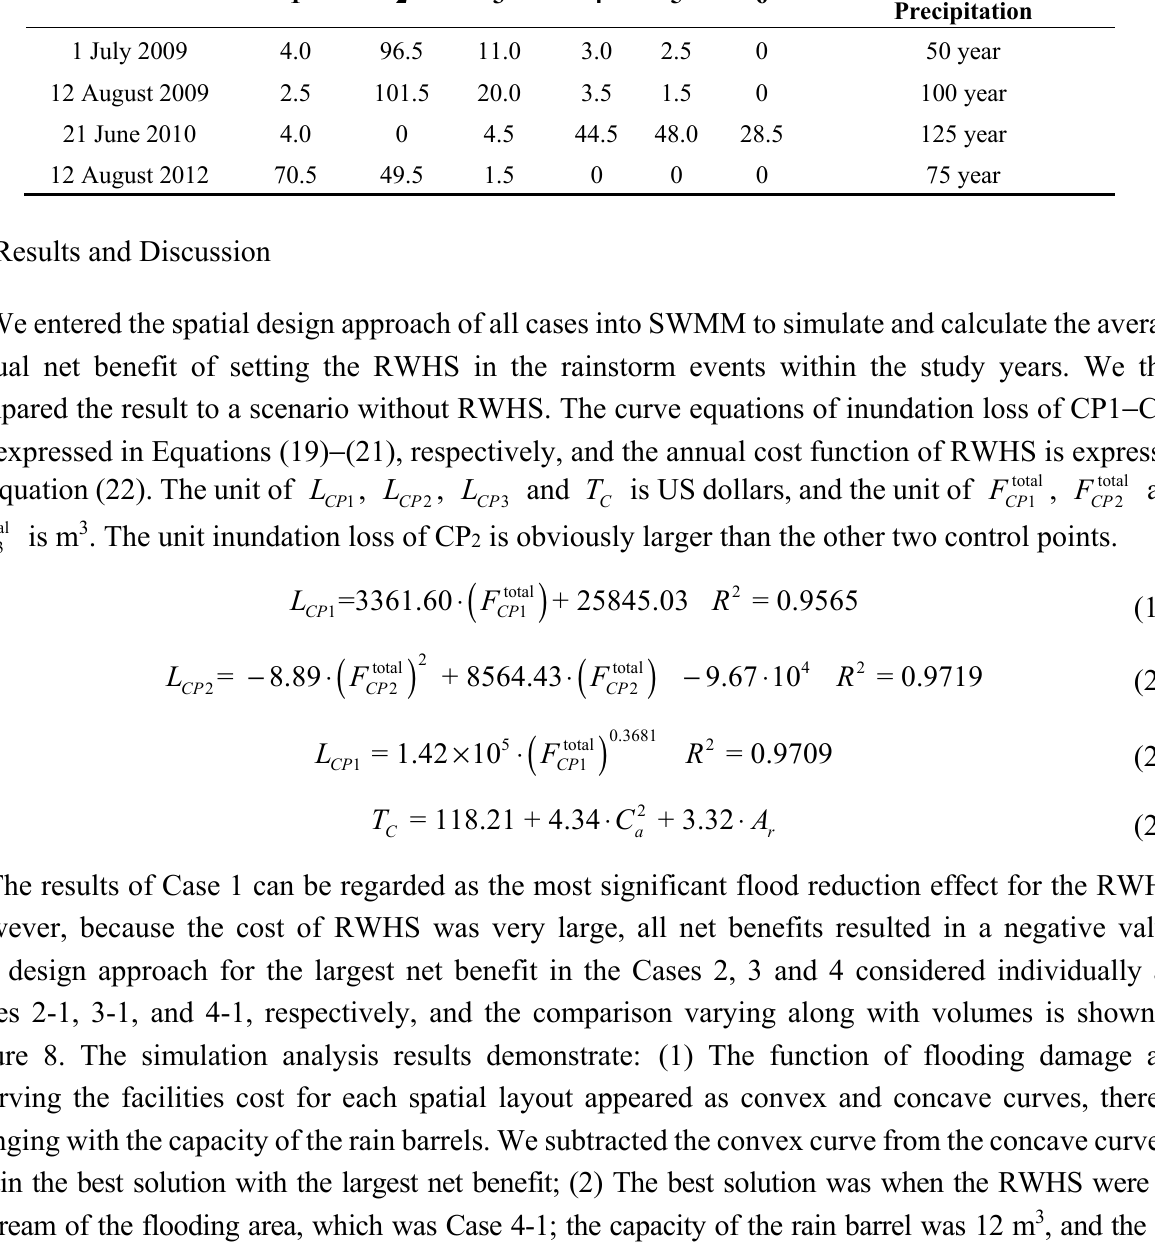
Table 3. Adopted precipitation hyetograph of rainstorm events for simulation-optimization (mm). Time Series Number (HOUR) Representative Return Period of Date